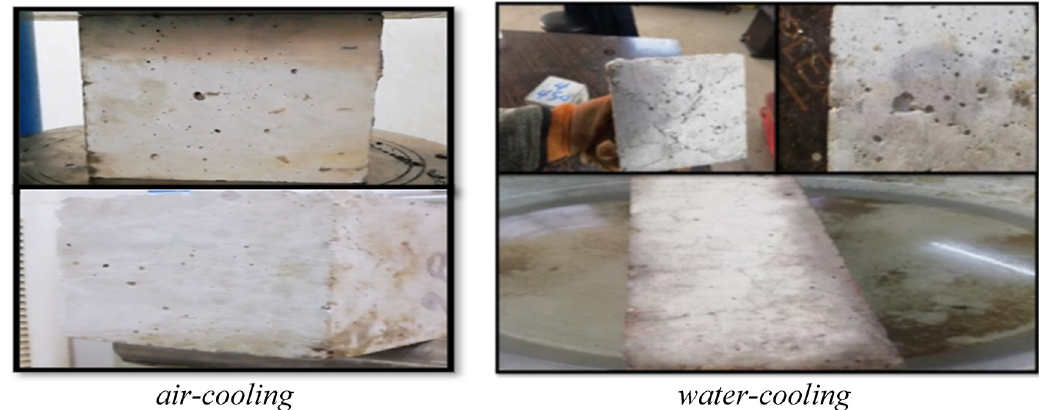
Figure 9: Visual inspection test of air - and water - cooling a ff